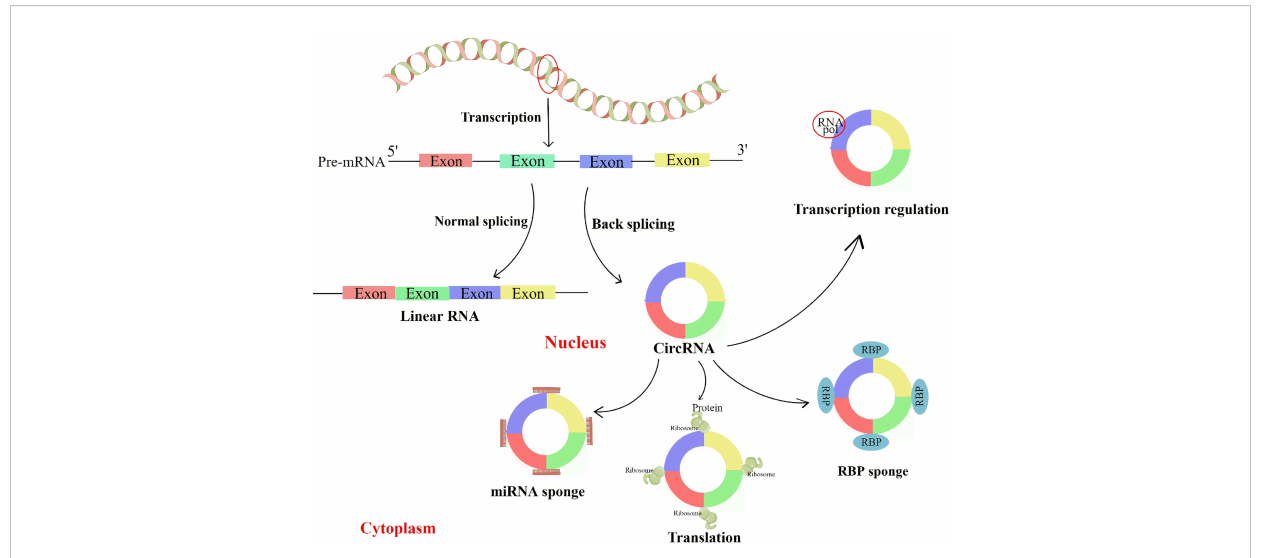
FIGURE 2 CircRNA regulates the transcription and splicing of parental genes by interacting with RNA polymerase II or transcription-related factors. CircRNA with miRNA binding sites can prevent miRNA from attaching to its target mRNA, thereby blocking the inhibitory effect of miRNA on target proteins. CircRNA can also interact with RNA binding protein (RBP) to regulate protein activity. Some circRNAs can be translated into